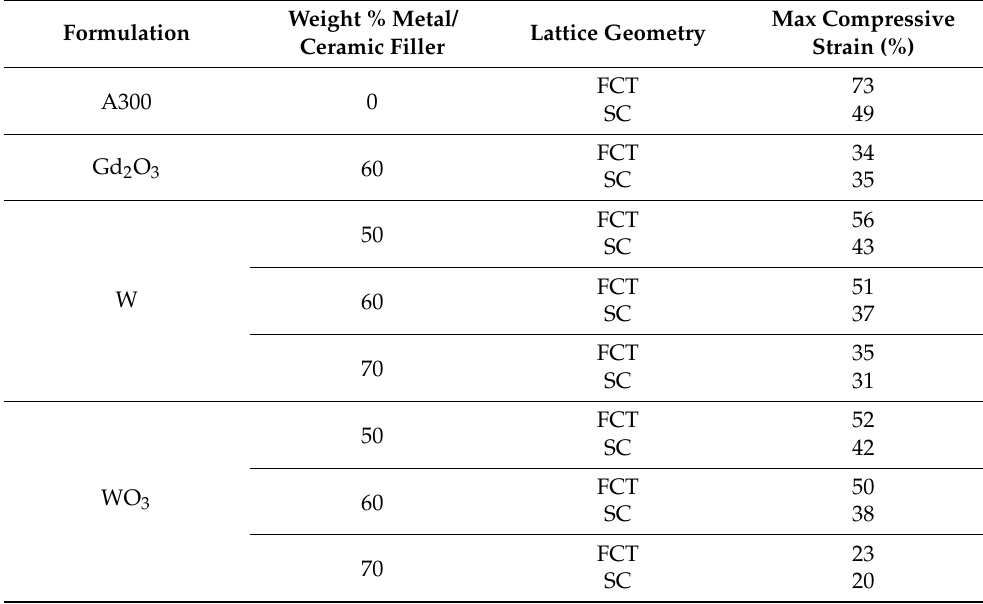
Figure 13. Compressive stress–strain curves for DIW pads with 500 µ m center-to-center distance between struts printed with: ( a ) FCT lattice geometry and ( b ) SC lattice geometry. Table 5. Maximum compressive strain (displacement) at 0.4 MPa for DIW pads printed at 500 µ m center-to-center distance spacing between